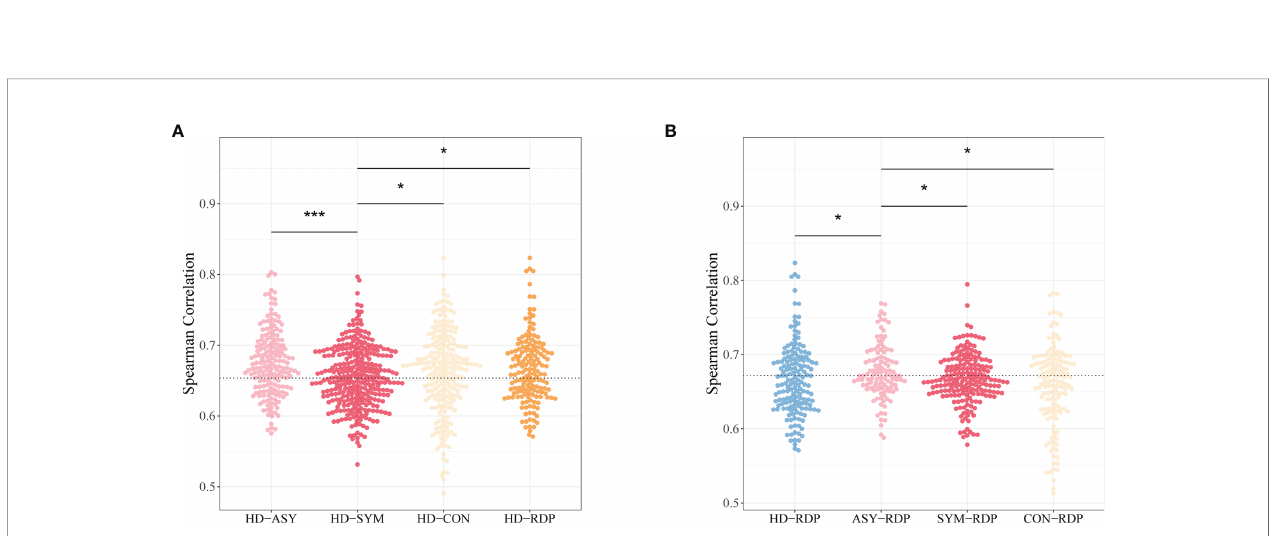
FIGURE 4 | Spearman ’ s correlation coef fi cients of V – J combination pro fi les between different groups. (A) The HD-ASY similarity is signi fi cantly higher than that of HD-SYM. (B) ASY showed the highest similarity to RDP among all groups. Statistical signi fi cance of the difference between groups is denoted as * for P < 0.05, *** for P <